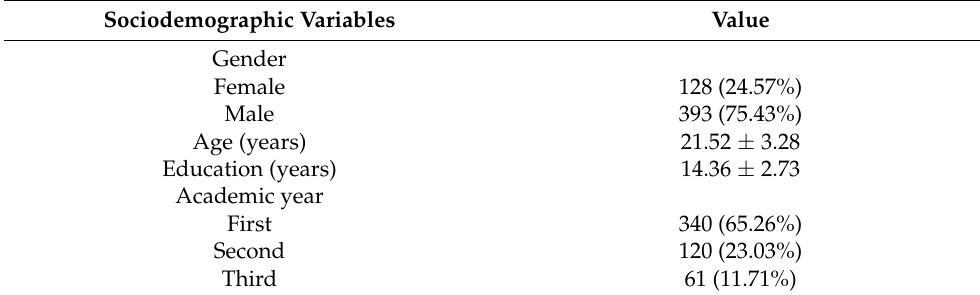
Table 1. Sociodemographic and characteristics of the students (n =